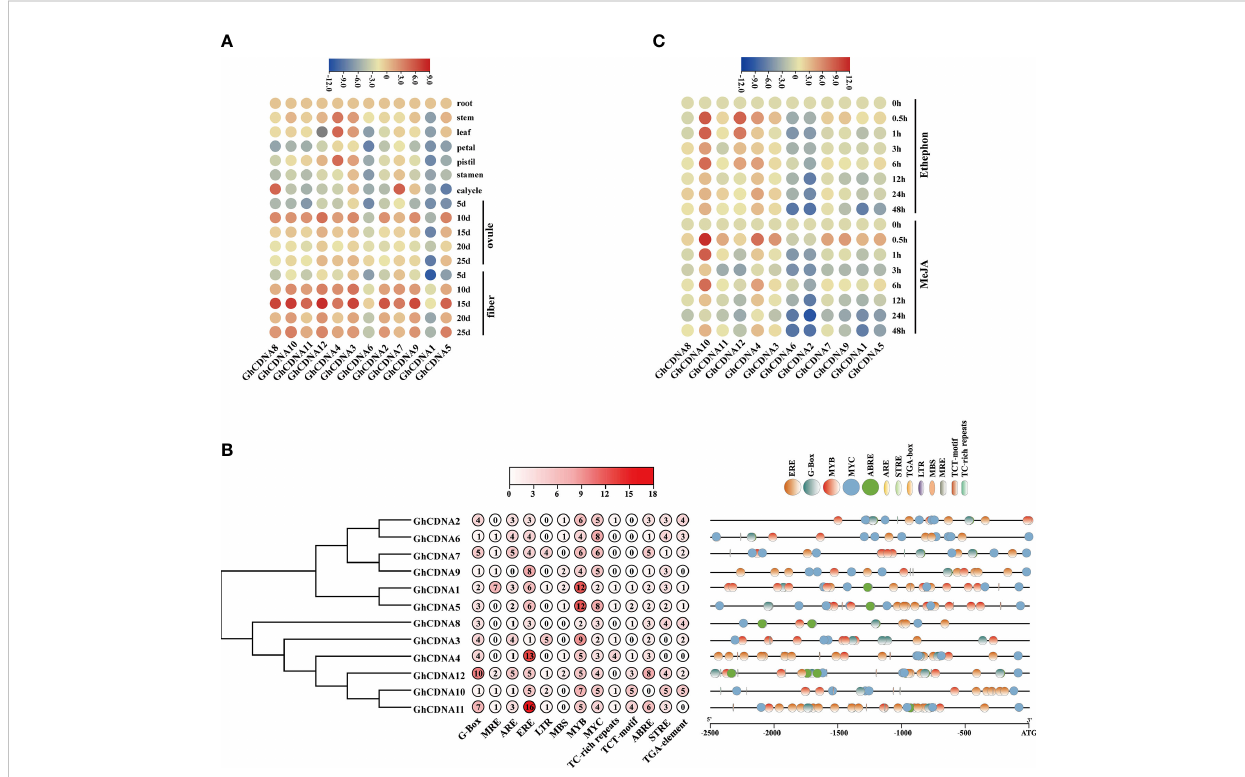
FIGURE 5 The promoter analysis and expression analysis of GhCDN-A gene family. (A) Heatmap of the quantitative real-time PCR of 12 GhCDN-A genes in 17 tissues. (B) The analysis of 2.5 kb promoter of 12 GhCDN-A genes, which successively shows the phylogenetic tree of GhCDN-A genes, the number of cis -regulatory elements, and the number of cis -regulatory elements. (C) Heatmap of the expression level of GhCDN-A genes in roots after treating with 50 m M MeJA and 50 m M ethephon.